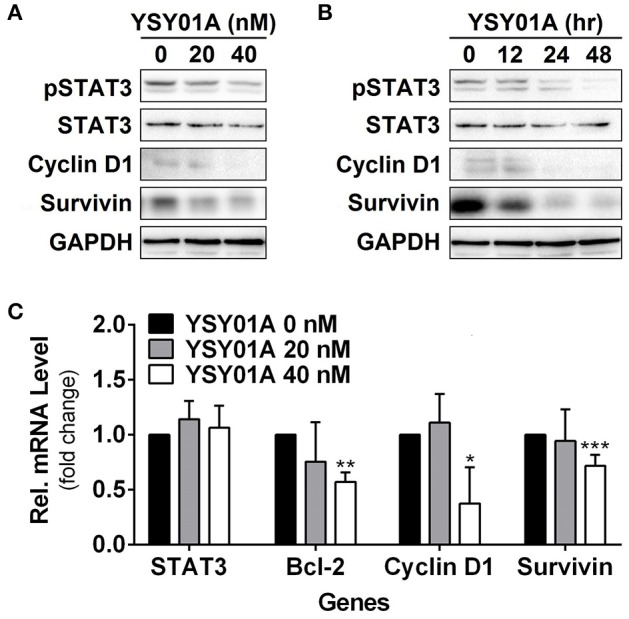
Effect of YSY01A on regulatory proteins important for cell proliferation and anti-apoptosis in A549 cells. (A,B) Expression levels of specific proteins important for cell proliferation and anti-apoptosis were analyzed by immunoblot analysis after A549 cells were exposed to 0 (vehicle control), 20 or 40 nM YSY01A for 48 h (A) or 40 nM YSY01A for 0, 12, 24, or 48 h (B). GAPDH was used as a loading control. (C) Following the treatment as indicated, A549 cells were harvested for real-time qPCR analysis of selected genes. GAPDH was used as an internal control. (*p < 0.05, **p < 0.01, ***p < 0.001, by Student's t-test as compared with vehicle control)